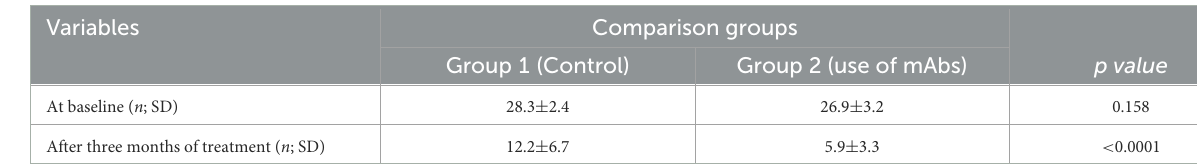
TABLE 4 Number of days per month of symptomatic medications use before and after treatment with monoclonal antibodies.